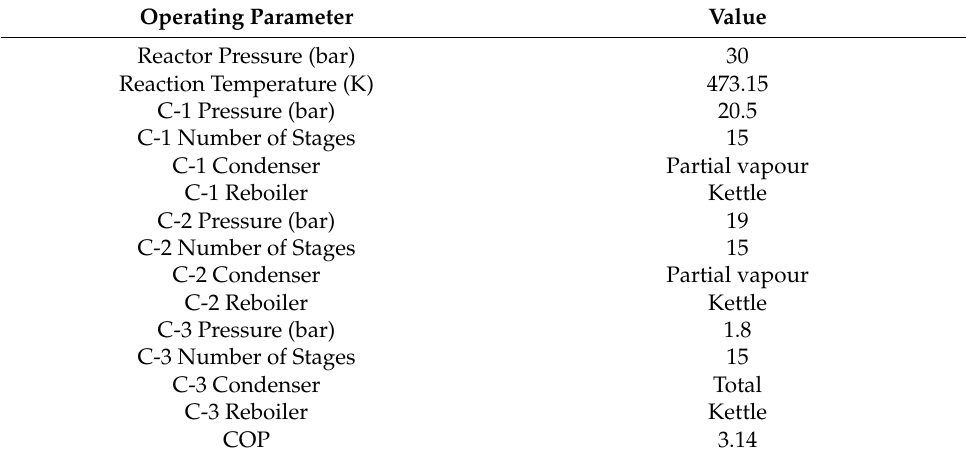
Table 4. DME production plant process